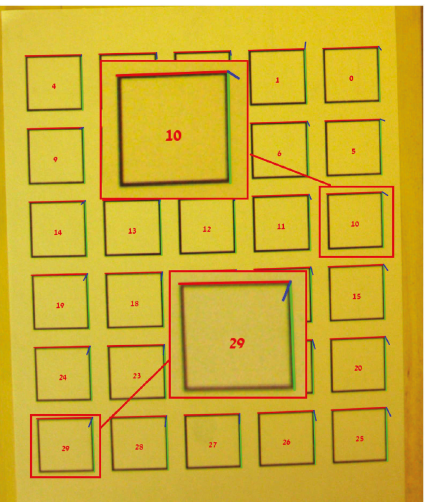
Figure 9: An example of normal detection results on some printed squares; note that target 10 and target 29 are oriented di ff erently with di ff erent computed normal vectors.